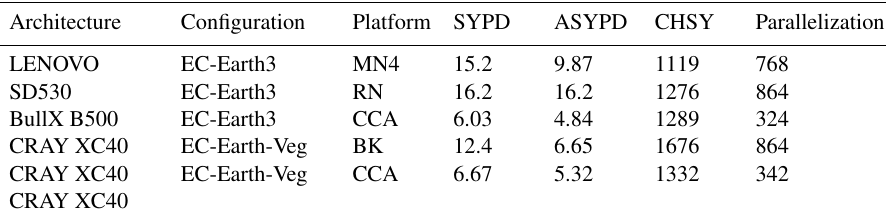
Table 11. Basic CPMIP metrics of EC-Earth3 and EC-Earth3-Veg with standard resolution for four different architectures and platforms: Marenostrum4 (MN4, LENOVO SD530), Rhino (RN, BullX B500), ECMWF-CCA (CCA, CRAY XC40), and Beskow (BK, CRAY XC40). The basic metrics are SYPD (simulated years per day), ASYPD (actual simulated years per day), CHSY (core hours per simulated year), and parallelization (number of MPI processes used). Architecture Configuration Platform SYPD ASYPD CHSY Parallelization LENOVO SD530 BullX B500 CRAY XC40 CRAY XC40 CRAY XC40